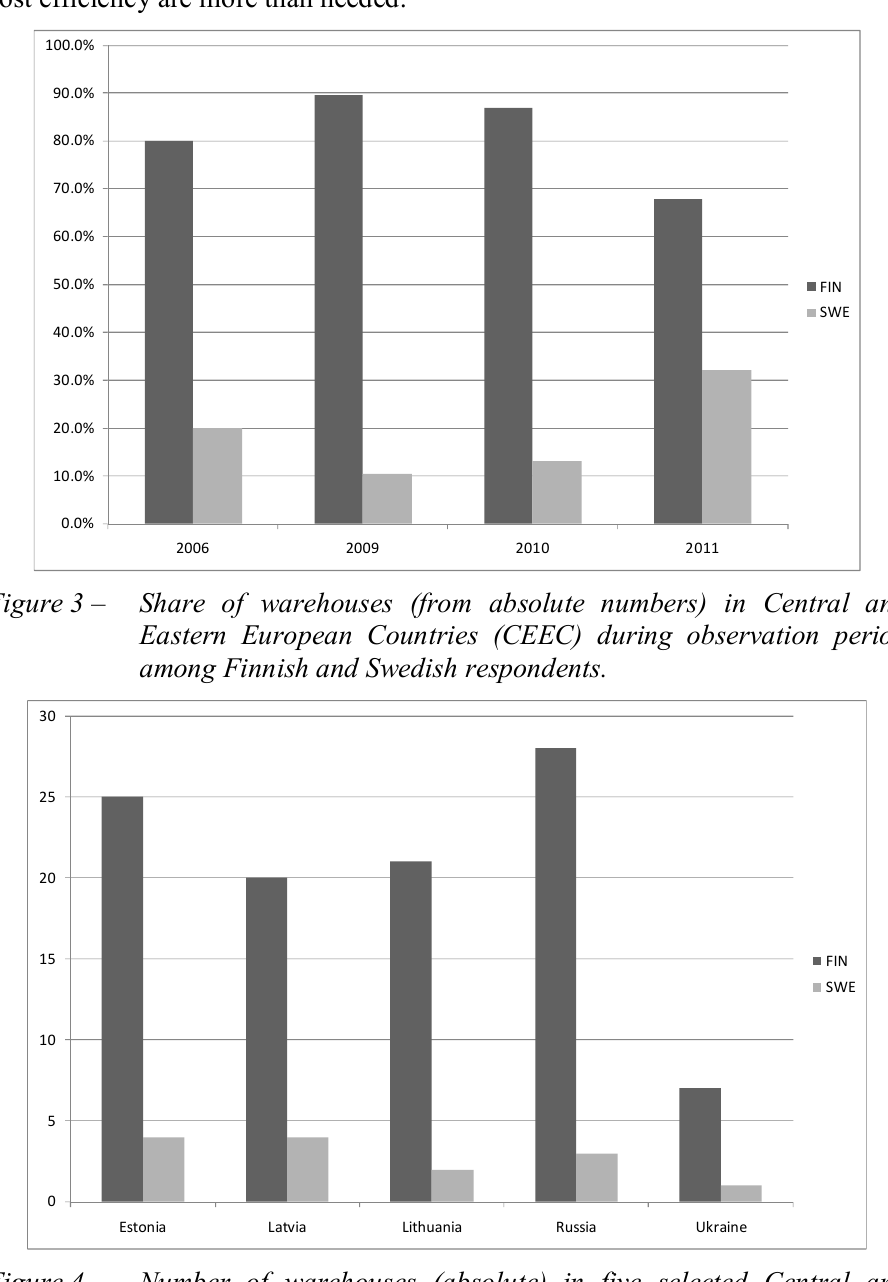
Figure 4 – Number of warehouses (absolute) in five selected Central and Eastern European Countries (CEEC) in total during observation period among Finnish and Swedish